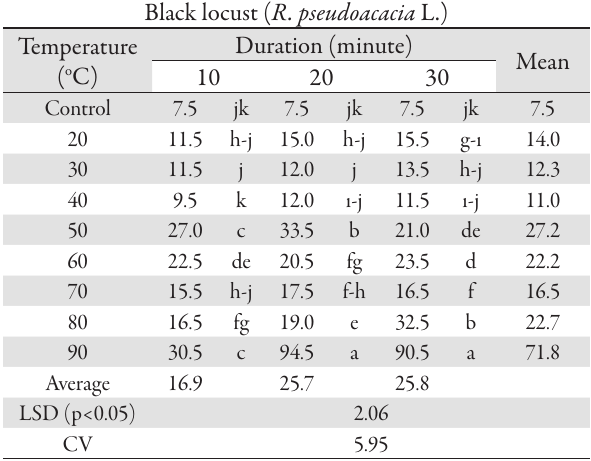
Tab. 2. The effect of different temperatures and durations on germination rates of honey locust ( Gleditsia triacanthos L.) seeds Honey locust ( G. triacanthos L.)